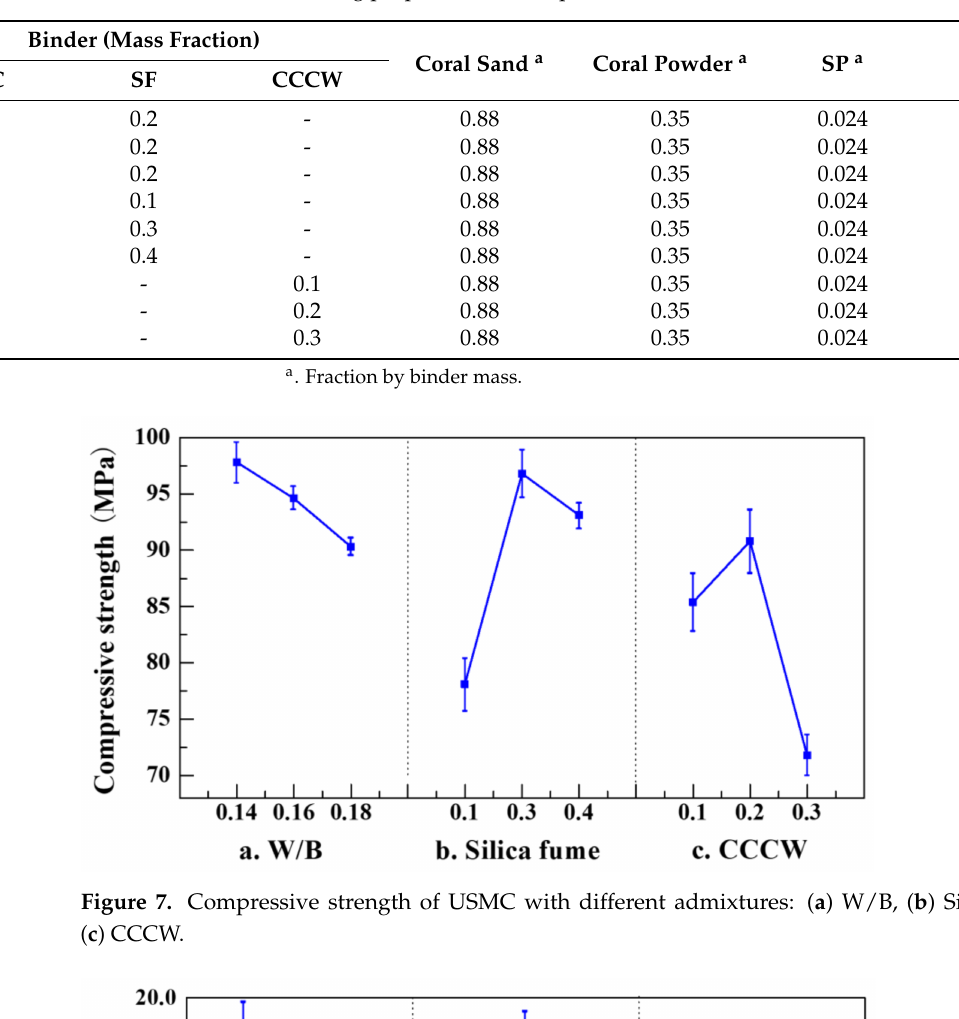
Table 5. Mixing proportions of samples.